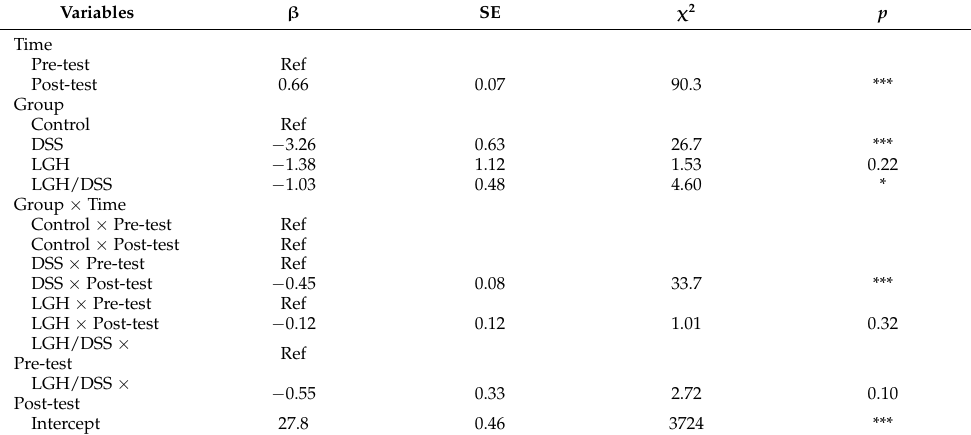
Results were obtained from generalized estimating equations (GEE) method. Model-based estimator with structure of AR1 correlation matrix was used. β , coefficient; SE, standard error; χ 2 , chi-squared test; DSS, dextran sodium sulfate; LGH, longish glucomannan hydrolysates; Ref, reference group; * p < 0.05, *** p <